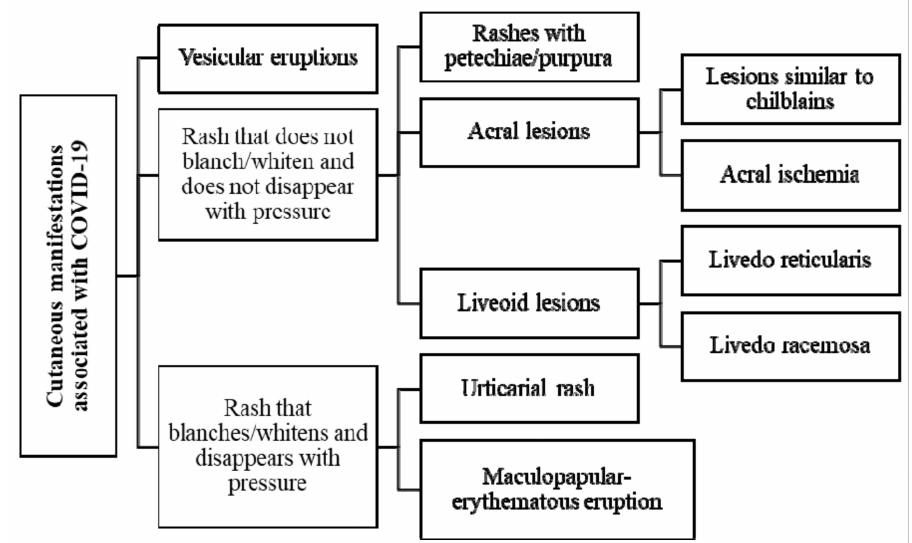
Figure 1. COVID-19 and skin